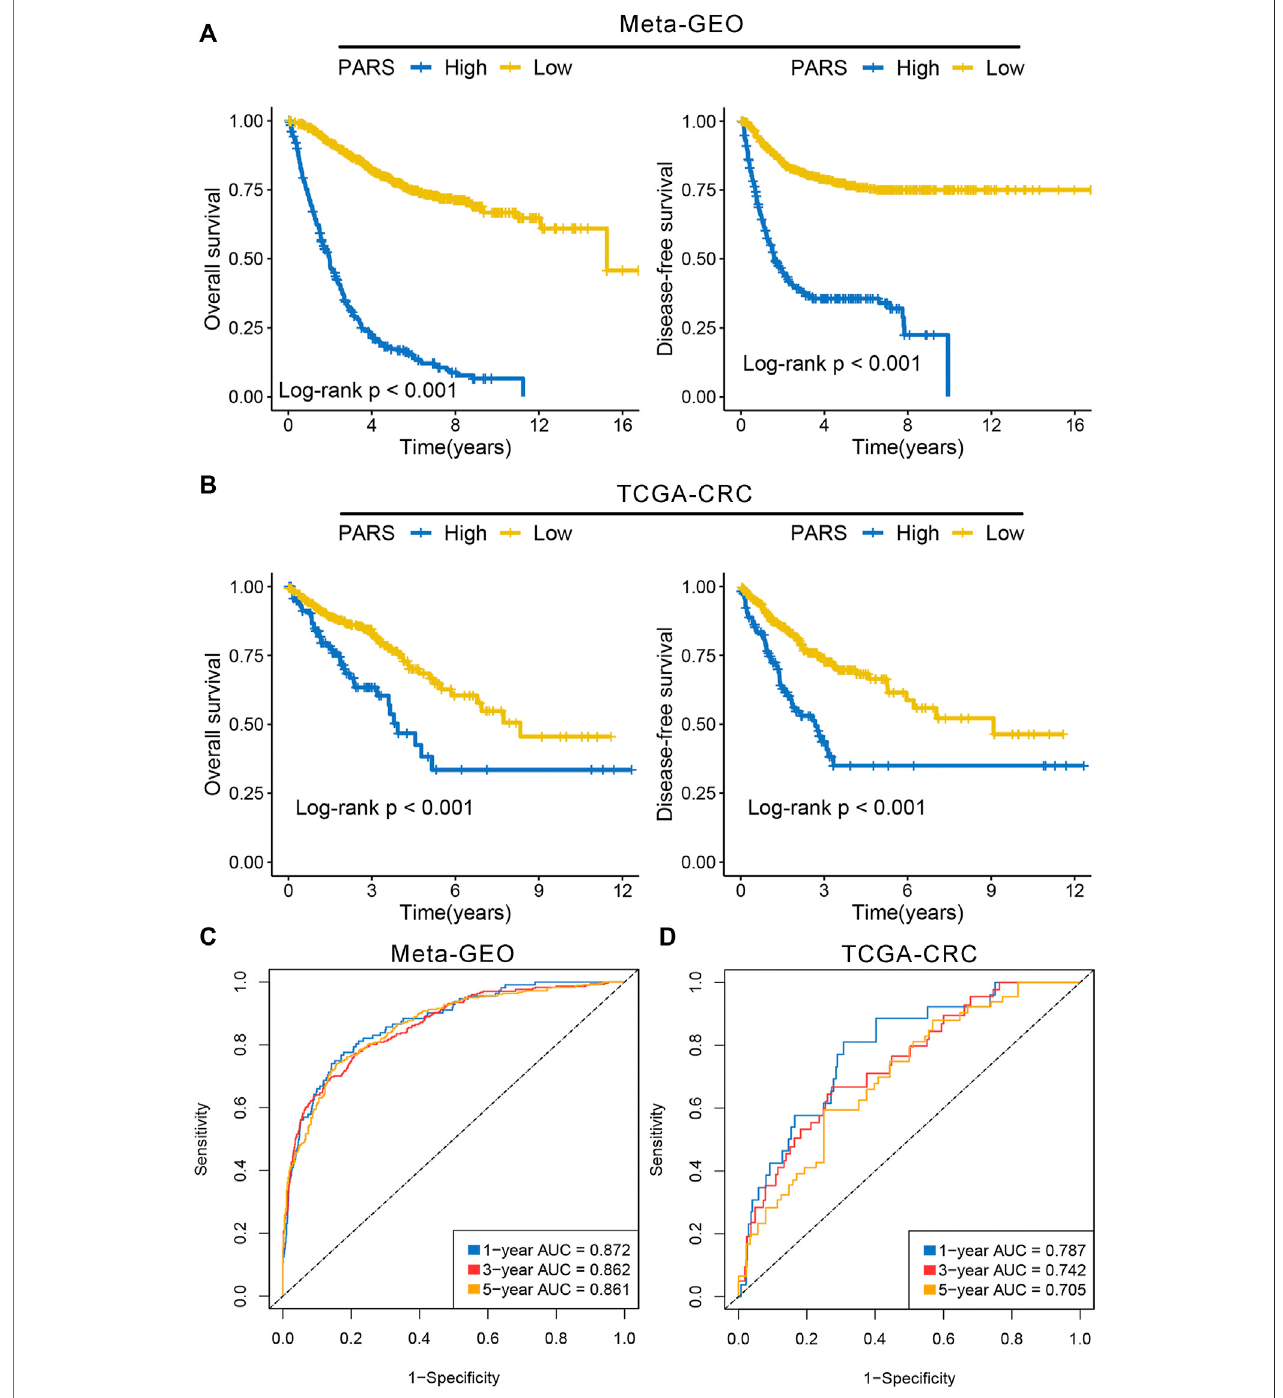
FIGURE 6 | Development of prognosis associated risk score. (A) Kaplan-Meier survival analysis of overall survival and disease-free survival according to PARS in the meta -GEO cohort. (B) Kaplan-Meier survival analysis of overall survival and disease-free survival according to PARS in the TCGA-CRC cohort. (C,D) ROC curves of PARS in the meta -GEO (C) and TCGA-CRC (D) cohorts.